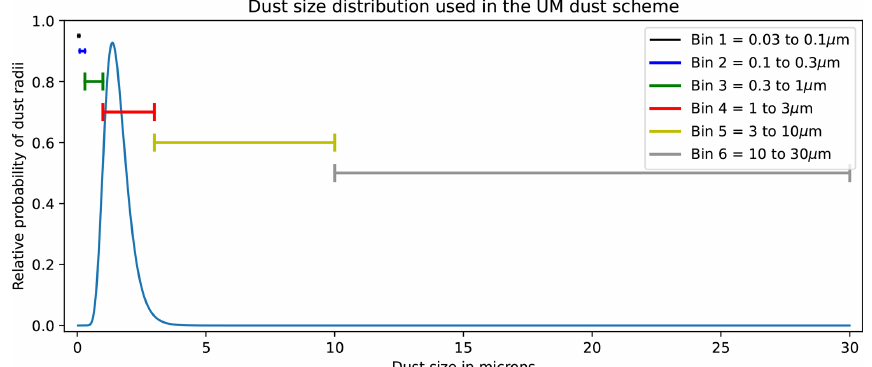
Figure 3. Dust size probability distribution used for the UM following Madeleine et al. (2011). Dust bin ranges are shown by the coloured bars.